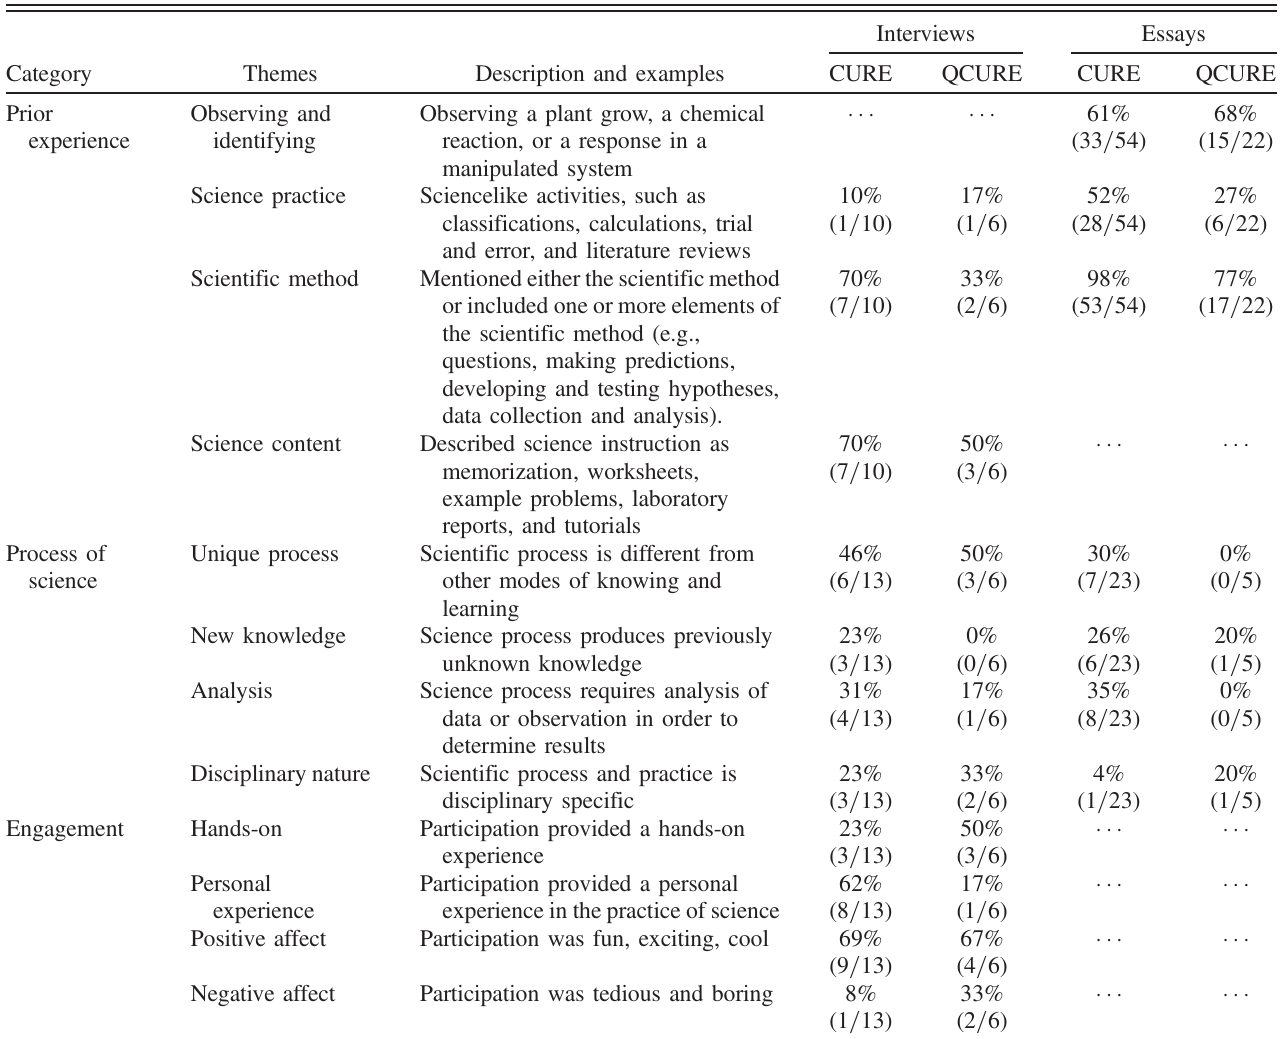
TABLE VII. Additional findings. Proportion of students mentioning themes, normalized to their participation in a CURE or a